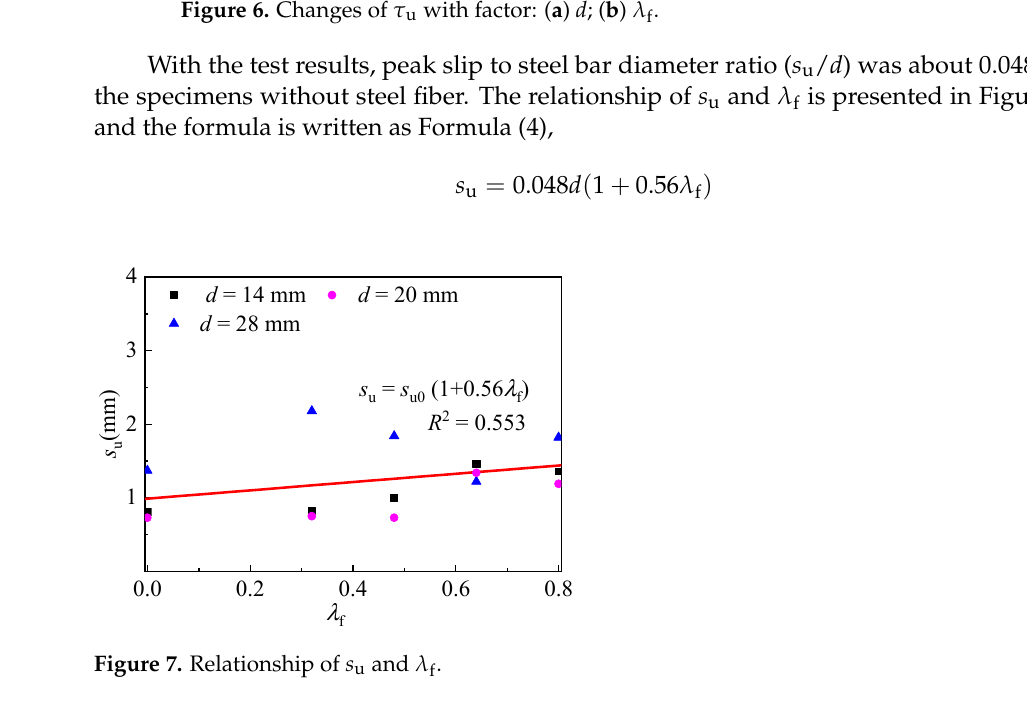
( b ) Figure 8. Comparison of test and calculated results: ( a ) bond strength τ u ; ( b ) slip s u . The relationship of bond stresses and slips at key points of complete bond stress-slip curves with the bond strength τ u and peak slip s u are presented in Figure 9. Based on the regression, τ s , τ cr , τ r were 0.68, 0.87, 0.29 times of τ u , while s s , s cr , s r were 0.24, 0.43, 9.51 times of s u , respectively. On account of the calculation method of these bond strengths and slips on the bond stress-slip curves, complete curves can be predicted by the prediction model in the absence of test data.